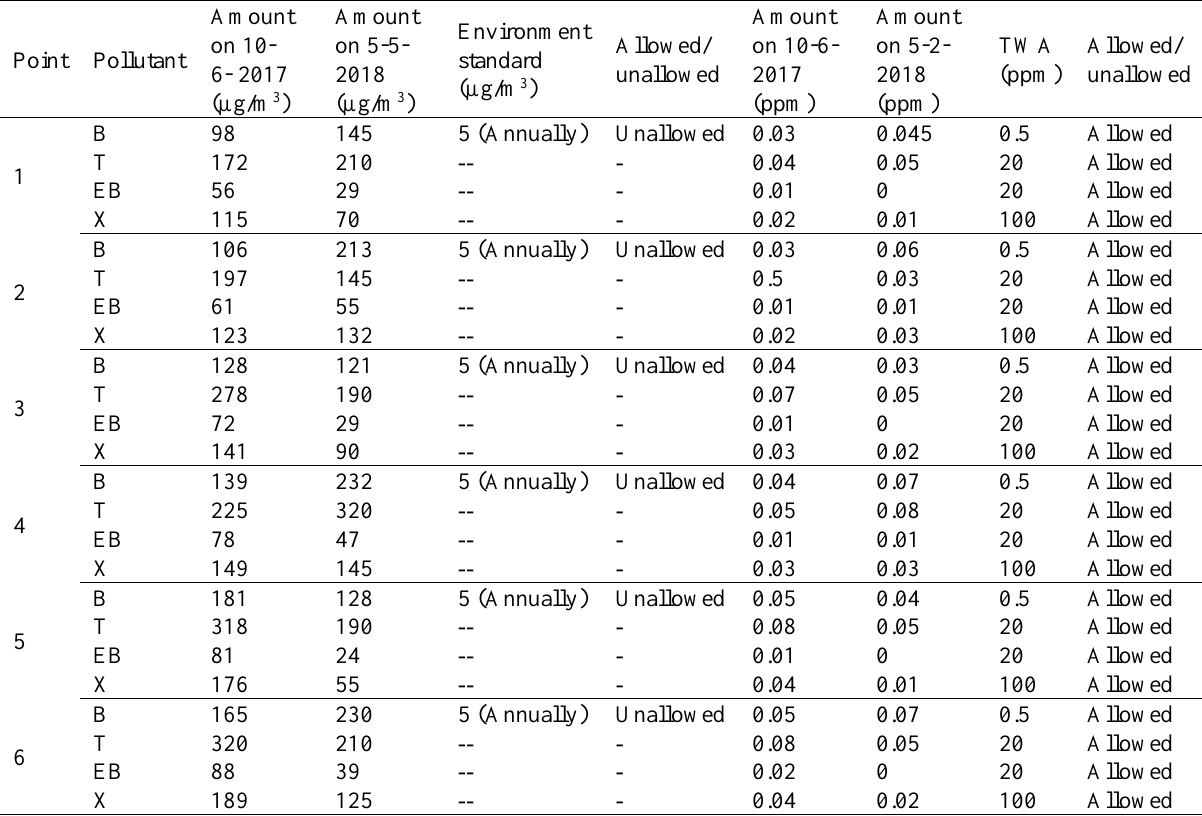
Table 4. Field measurement results in cold and hot seasons